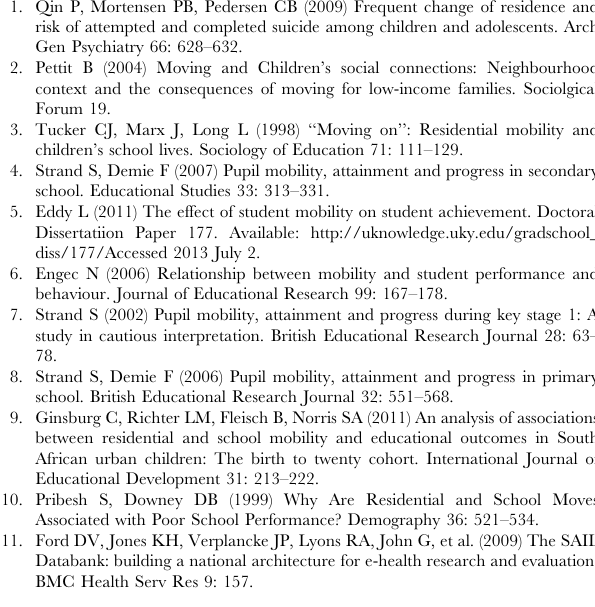
Table S1 Confounder variable tables for residential and school moves (complete case analysis; n= 121,442). Table S2 Association between residential moves and educational outcomes with interactions adjusted for all variables shown in the table (Odds ratios and 95%